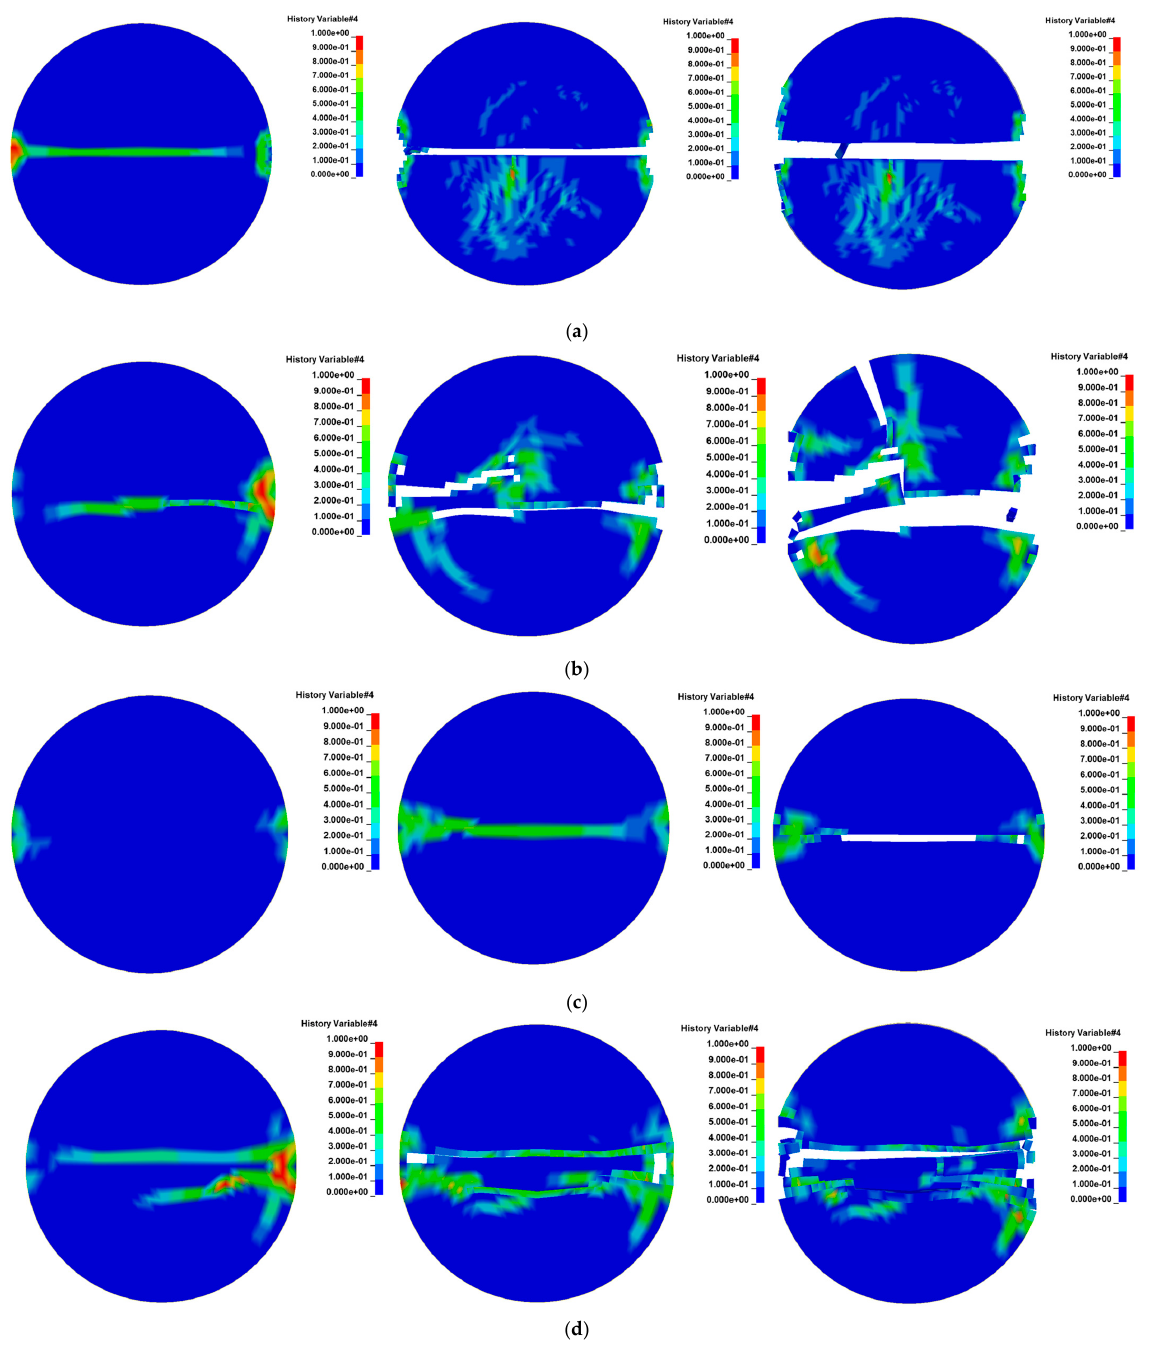
Figure 15. Failure process simulated by splitting tensile test: ( a ) PC-25 °C; ( b ) PC-800 °C; ( c ) S1PP0.2- 25 °C; ( d ) S1PP0.2-800 °C.